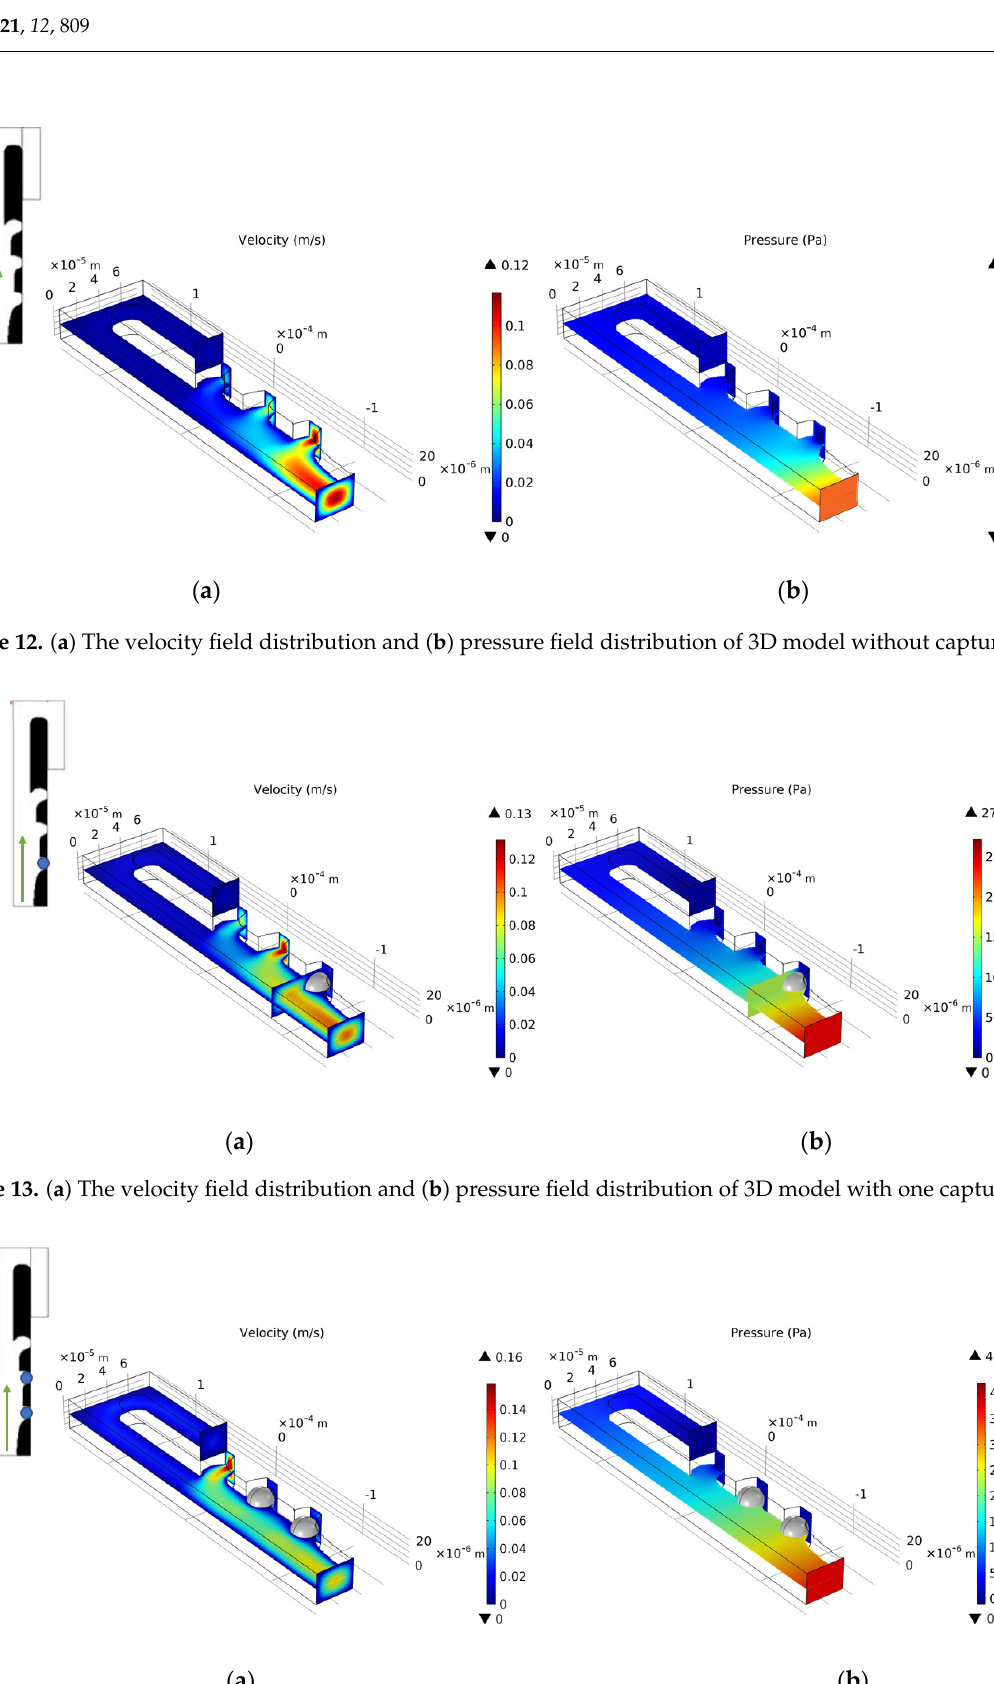
( b ) Figure 15. (a) The velocity field distribution and ( b ) pressure field distribution of 3D model with three captured cells. Figure 16. The flow rate ratio among each outlet of the three-cell capture unit and the bypass outlet under different numbers of captured cells.